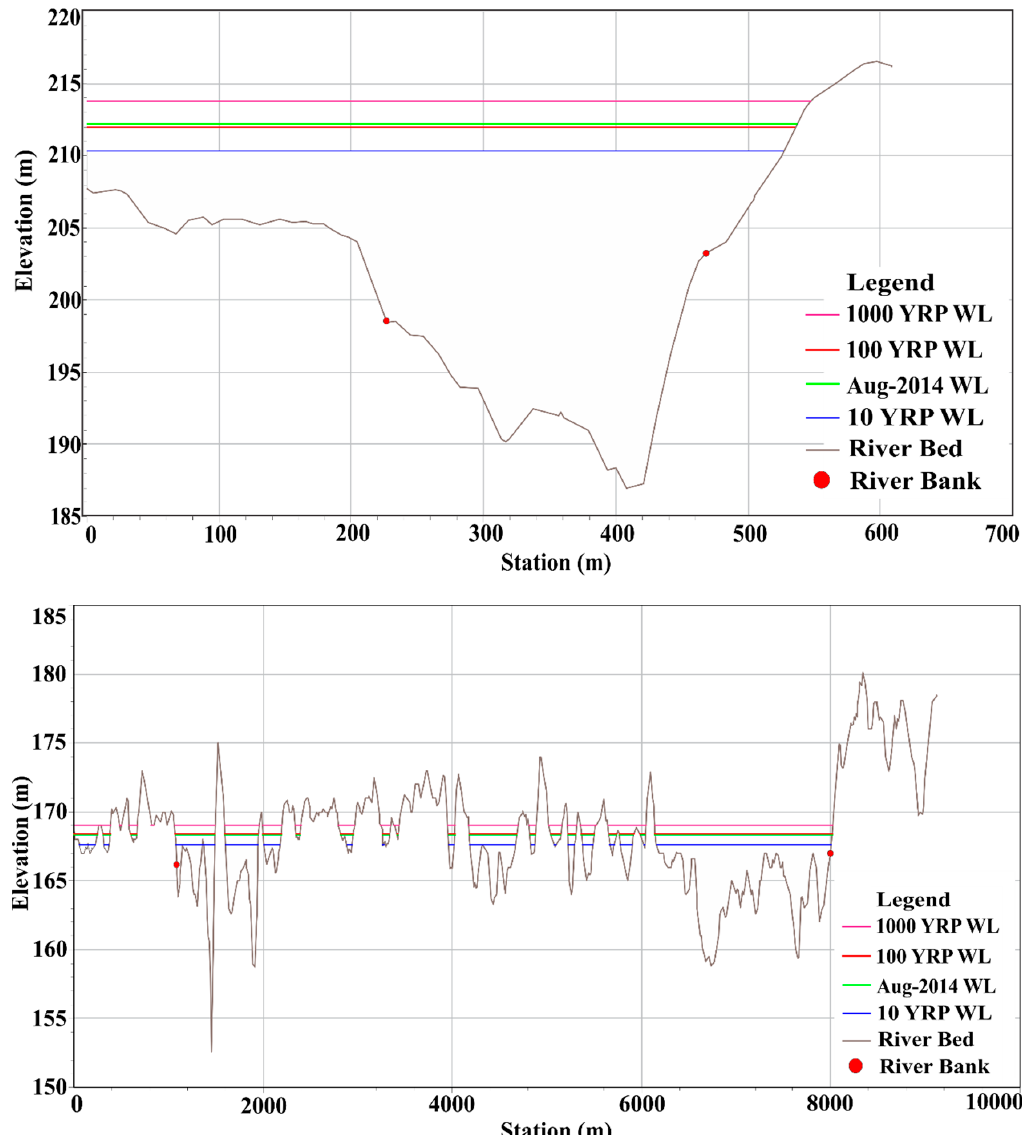
Figure 9. Water surface elevation (WL) in cross sections at Chisapani under different YRP floods, including the 2014 flood (around the 100-YRP) ( upper ), and WL at the Satighat cross section ( lower ).